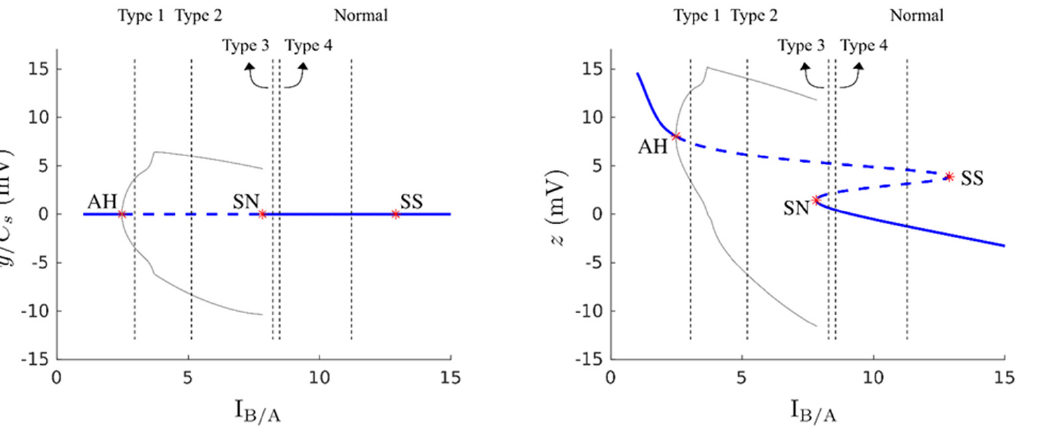
Figure 8. Bifurcation analysis of the model output, z, and the simulated EEG machine output, y, of the epilepsy model with respect to B/A. The blue line is the equilibrium continuation curve, where the solid segments correspond to stable fixed points and the dashed segment to unstable fixed points. Bifurcation points are represented by red stars. AH indicates the Andronov–Hopf bifurcation, SS the saddle–saddle bifurcation, and SN the saddle–node bifurcation. Gray solid curves correspond to the extremal values of limit cycles. The five vertical dashed black lines show the corresponding values of B/A used to generate the five types of simulated EEG activities when the parameter A was fixed at 5 (as shown in the upper row of Figure A1).